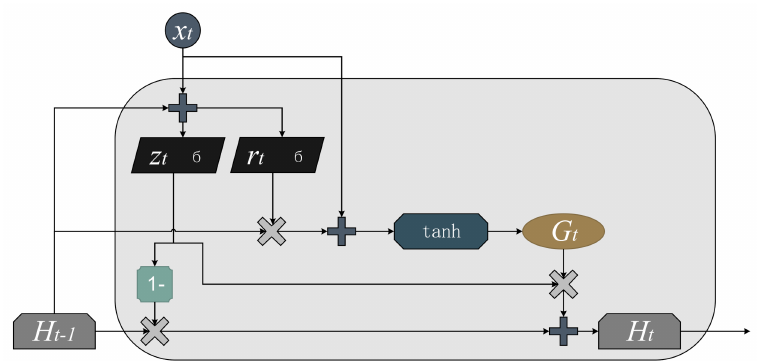
Figure 5. Gated recurrent units (GRU) model structure in a single time step (where z t is the